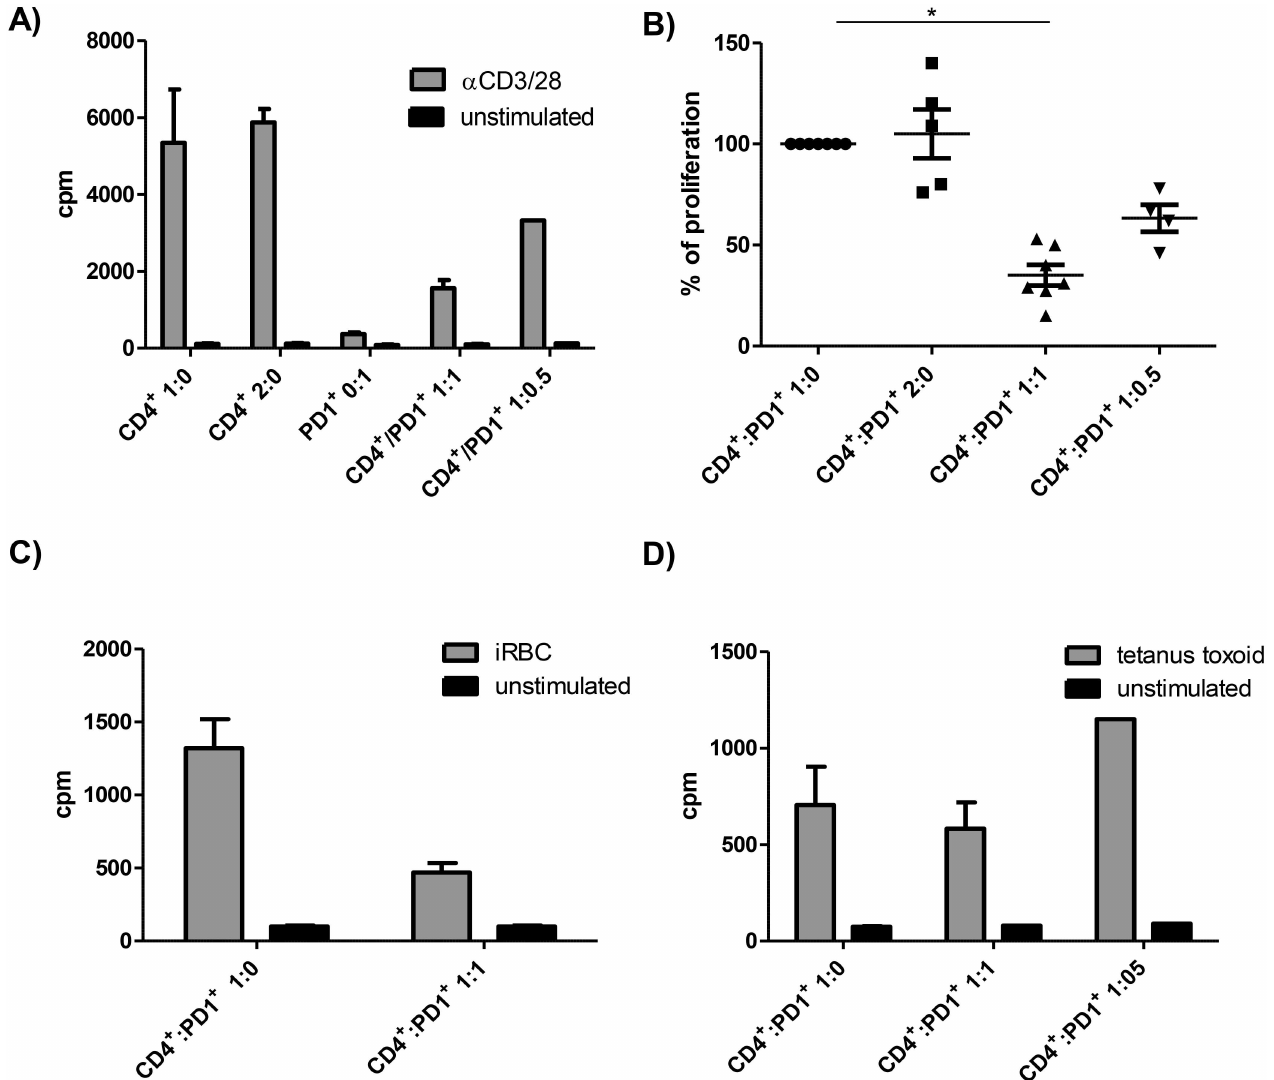
Fig 4. Malaria-induced PD1 + CTLA4 + CD4 + T cells suppress CD4 + T cell proliferation. Cell cultures were set up by stimulating CD4 + T cells with anti-CD3/28 (A and B), iRBCs (C) or tetanus toxoid (D) with/without additionof FACS sorted PD1 + CTLA4 + CD4 + T cells (ratio 1:0, 1:1, 1:0.5). 3 H-Thymidine uptake was measured after 120 hrs of culture to assess cell proliferation. Cultures were performed in triplicates unless there were insufficient cells, and values represent mean + SE. A) shows the absolute proliferationcounts per minute for 2.5 x 10 4 anti-CD3/28 stimulated CD4 + T cells (ratio 1:0), 5x 10 4 CD4 + T cells (ratio 2:0), 2.5 x 10 4 PD1 + CTLA4 + CD4 + T cells (0:1) and 2.5 x 10 4 CD4 + T cells with equal (ratio 1:1) or half the numbers (ratio 1:0.5) of PD1 + CTLA4 + CD4 + T cells for one representative malaria patient out of 7. Adding twice the number of CD4 + T cells, 5 x 10 4 cells, (2:0), was includedas a control conditionto exclude higher cell numbers as a cause for suppressed cell